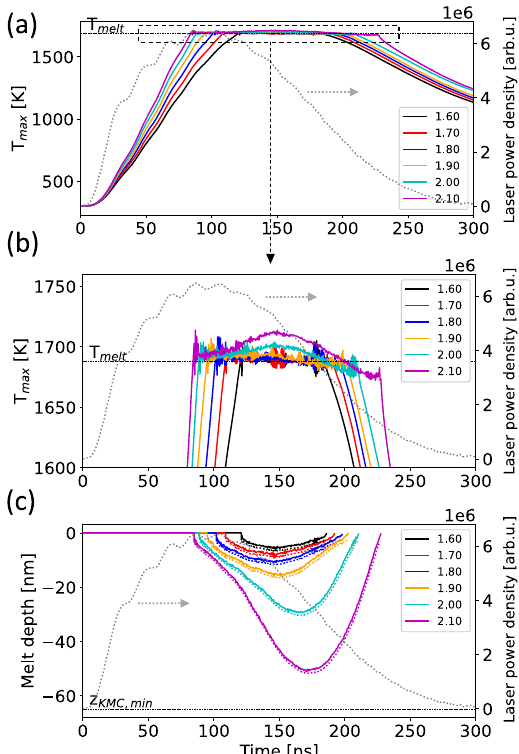
Fig. 6 FEM-KMC results for various fl uences and benchmark for latent heat computation. a Maximum T value in the FEM mesh as a function of time (solid lines), for several values of laser energy density, ranging from 1.6 to 2.1 J cm − 2 . The laser density of the laser pulse over time is also shown as black dotted line. b Zoom of the curves in ( a ) around T M . c Variation of melt-depth over time for the same fl uences, extracted as average z coordinate of solid Si atoms at the interface at the end of every KMC step (solid lines), in comparison with the melt depths estimated by means of the exchanged latent heat (dashed lines) as described in Eq. (7). The maximum accessible depth for melting in the KMC box, z KMC , is also indicated as a black dashed line.